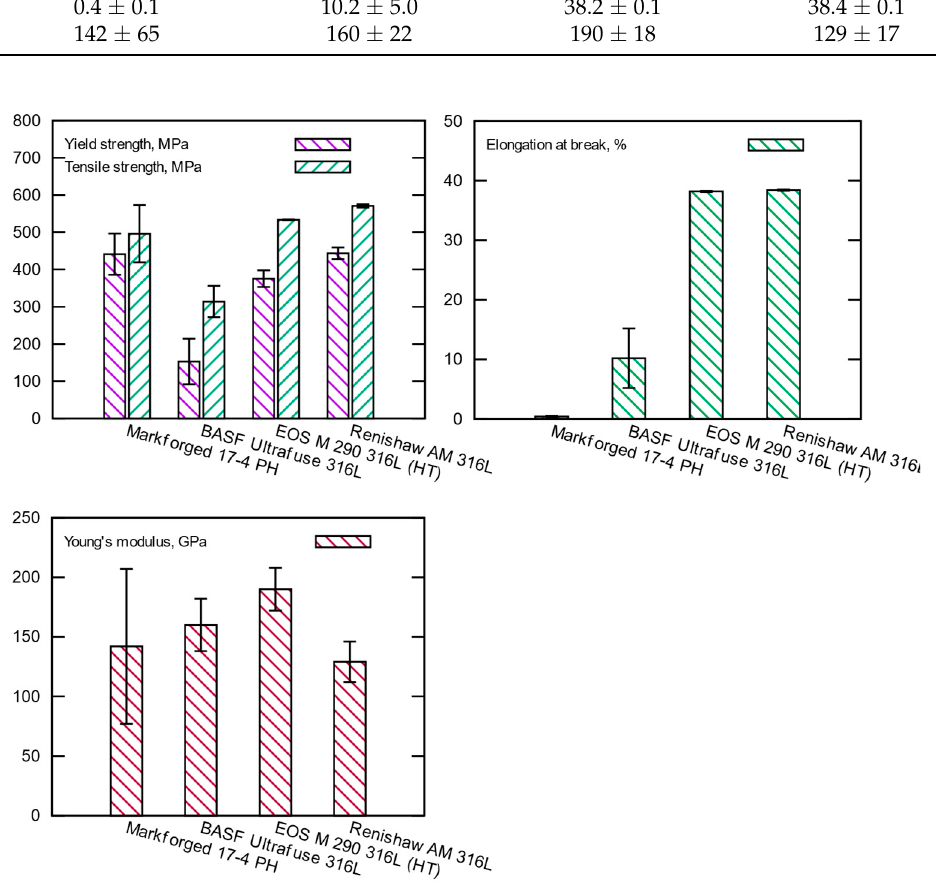
Figure 5. Results of tensile tests (mean with +/ − standard deviation).